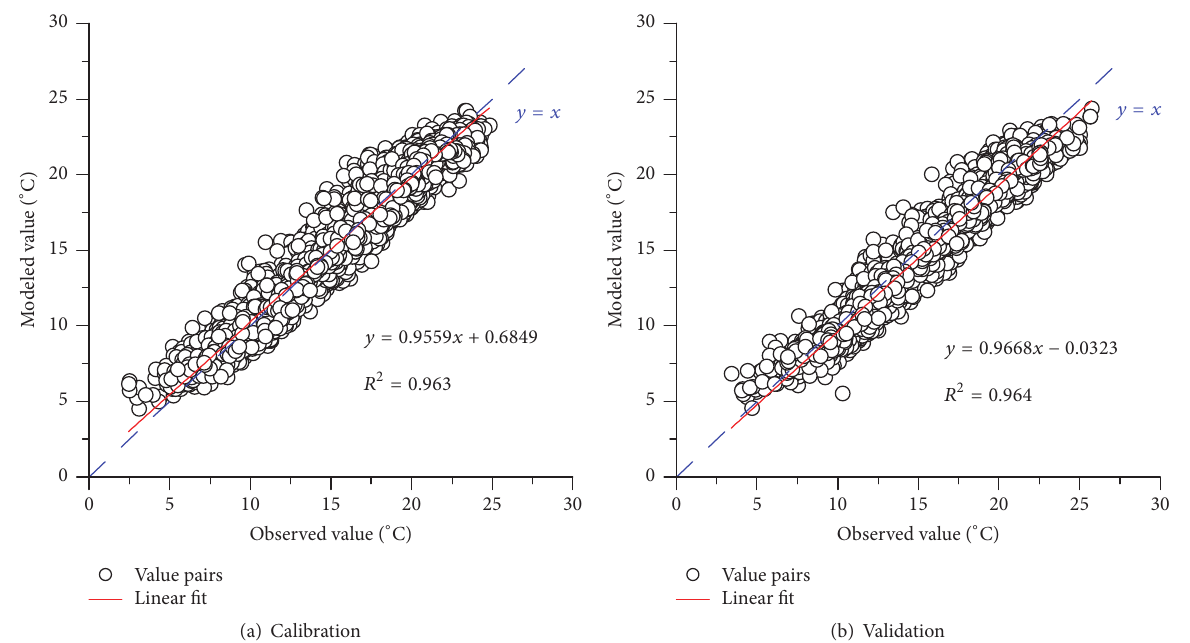
Figure 3: Scatter plots of daily mean temperature between modeled and observed series during calibration and validation periods.